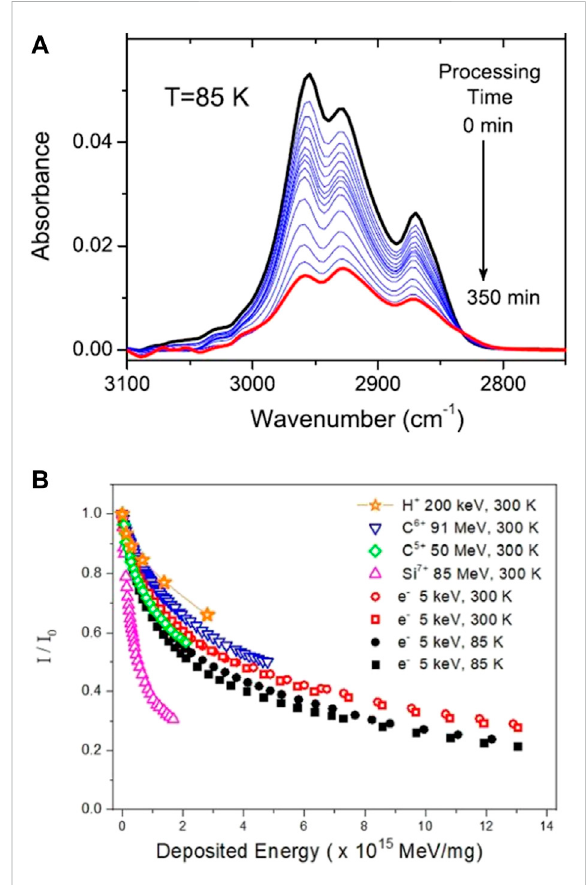
FIGURE 6 (A) : Evolution of the 3.4 μ m band of an a-C:H deposit under irradiation by 5 keV electrons. Deposit from CH 4 /He RF discharge, thickness ≈ 520 nm, fl ux ≈ 7.9×10 12 electronscm − 2 s − 1 . (B) :Decayof the intensity of the 3.4 μ m band of a-C:H interstellar dust analogs as a function of the deposited energy. Red and black symbols: electron irradiation (Maté et al., 2016). Rest of the symbols: ion irradiation, Godard et al. (2011). Reproduced from, ApJ, 831, 51. In the original publication by Maté et al. (2016) there were errors in the legend that have been corrected